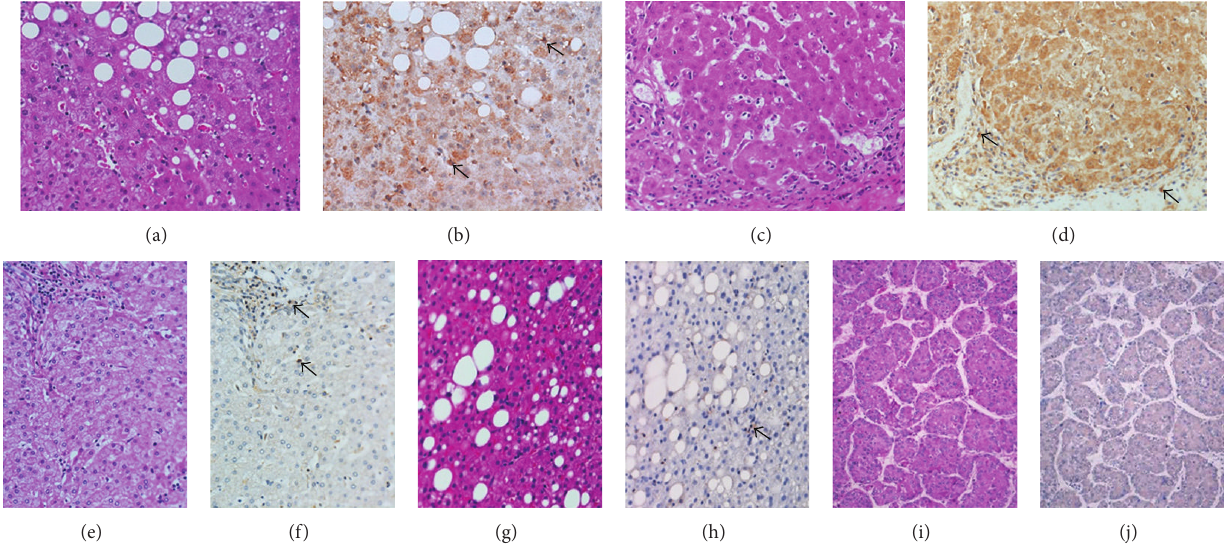
Figure 3: HCV-RNA localization with LNA-based ISH in FFPE biopsy or surgical specimens of the liver. ((a), (b)) Case 10 with chronic hepatitis C, ((c), (d)) case 11 with chronic hepatitis C, ((e), (f)) case 15 with chronic hepatitis B (noncancerous portion of a surgical case for HCC), ((g), (h)) case 13 with fatty liver, ((i), (j)) case 16 with surgically removed hepatitis-C-related HCC, ((a), (c), (e), (g), (i)) HE stain, and ((b), (d), (f), (h), (j)) LNA-based ISH. In HCV-infected human livers, the HCV-RNA signals are demonstrated in a focal/partial pattern (b) or in a diffuse pattern (d). Signals are not demonstrated in the hepatocytes of HBV-infected liver (f), fatty liver (h), and hepatitis-C-related HCC (j). Nonspecific binding of the reagent to Kupffer cells and lymphoid cells is occasionally observed (arrows in the panels (b), (d), (f), and